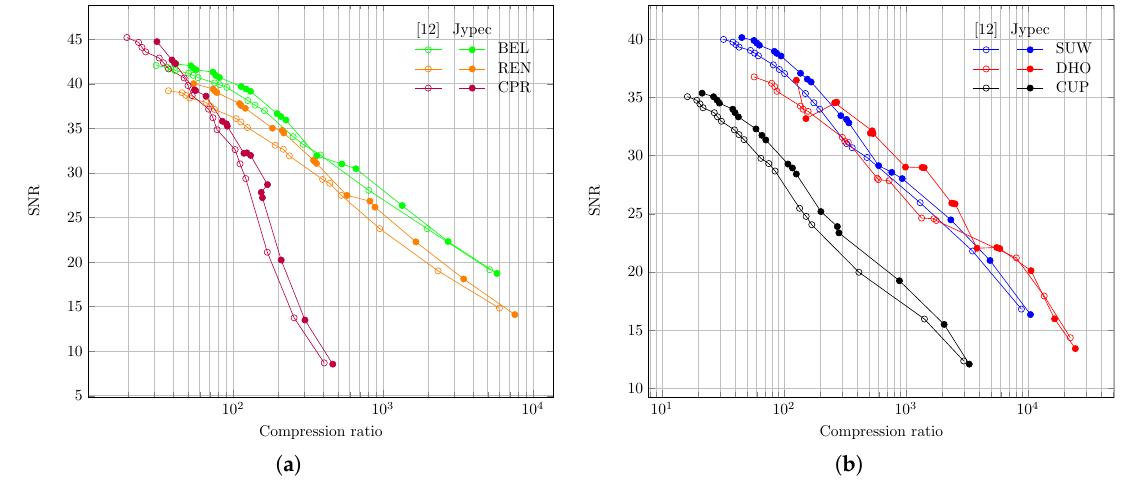
Figure 9. Distortion-ratio performance comparison between the work done in [12] and the algorithm developed here. Except in some isolated cases, Jypec achieves better distortion-ratio performance, having higher SNR for the same compression ratio and higher compression ratio for the same SNR.